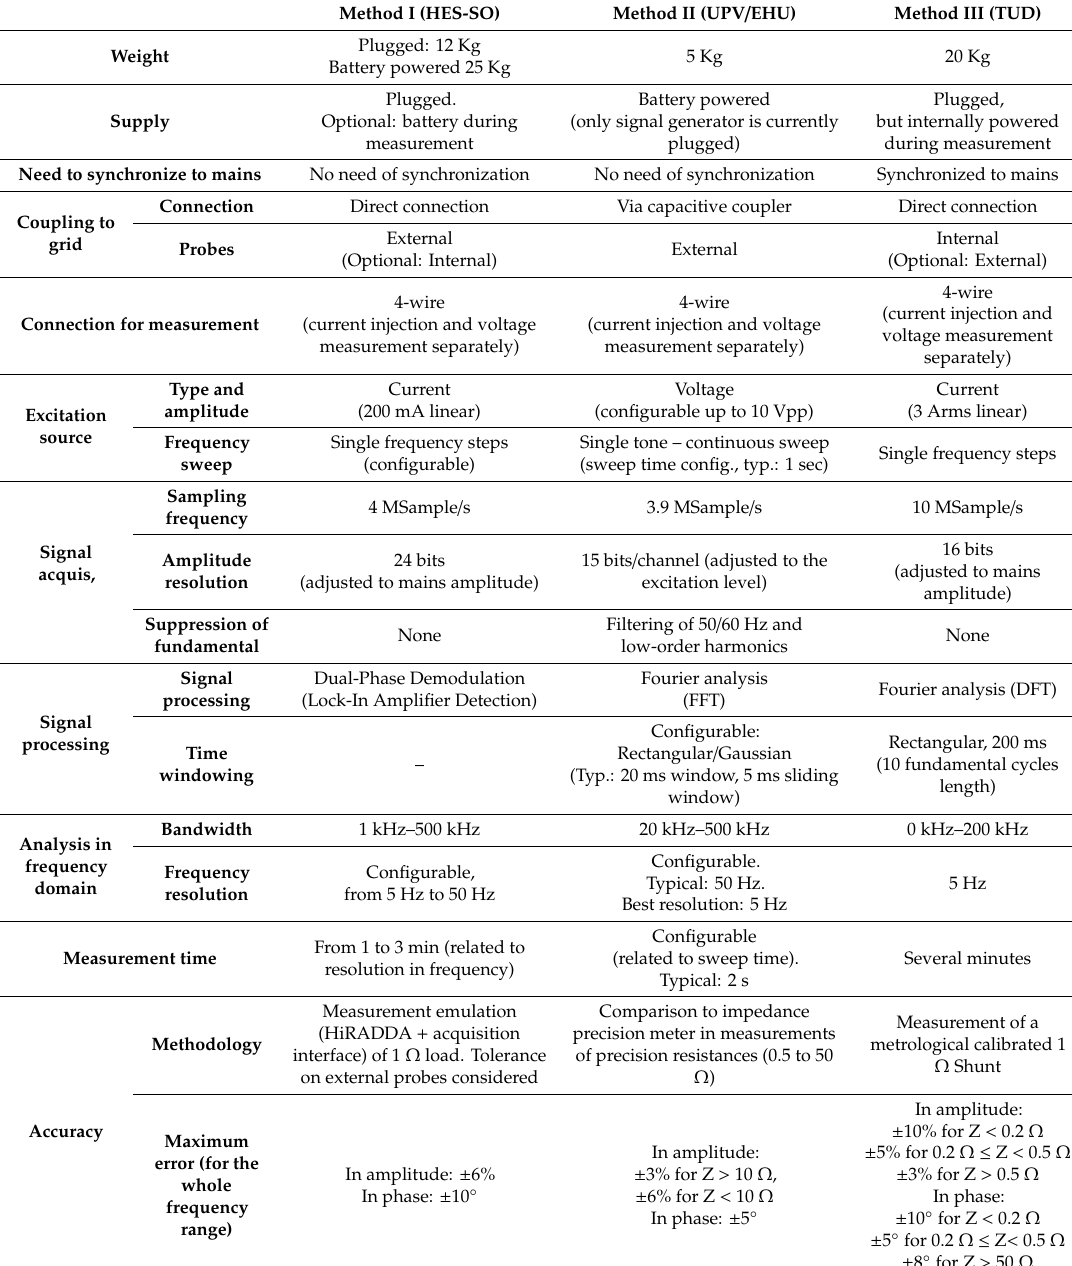
Table 1. Summary of the main characteristics of the proposed measurement